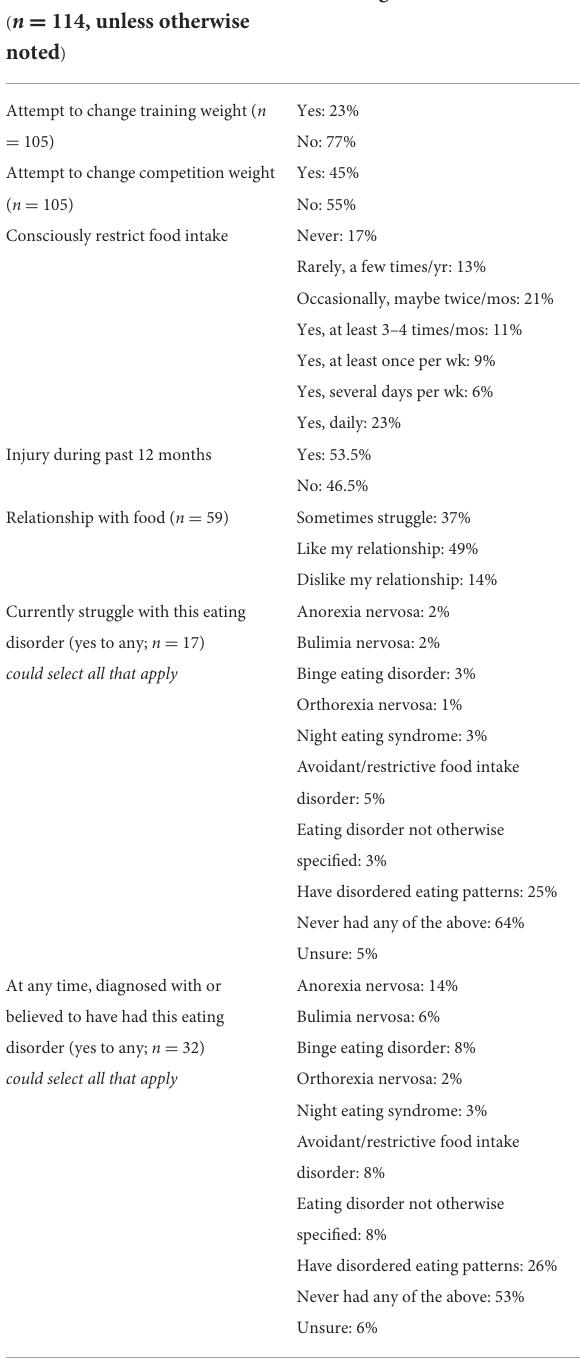
TABLE 3 Body weight manipulation and eating